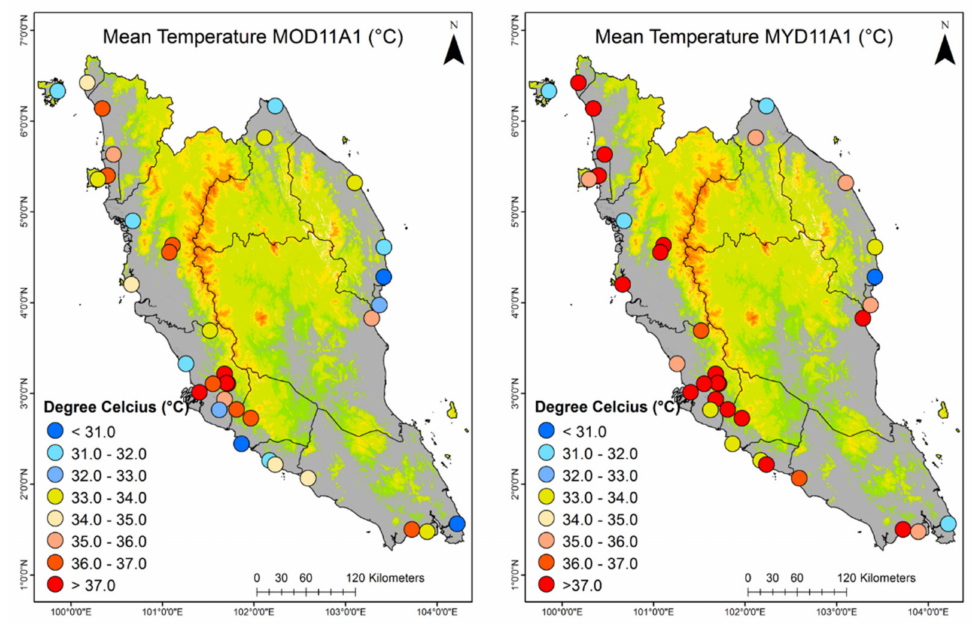
Figure 4. Mean T s in degree Celsius ( ◦ C) for daily MOD and MYD data from 2003 to 2016.